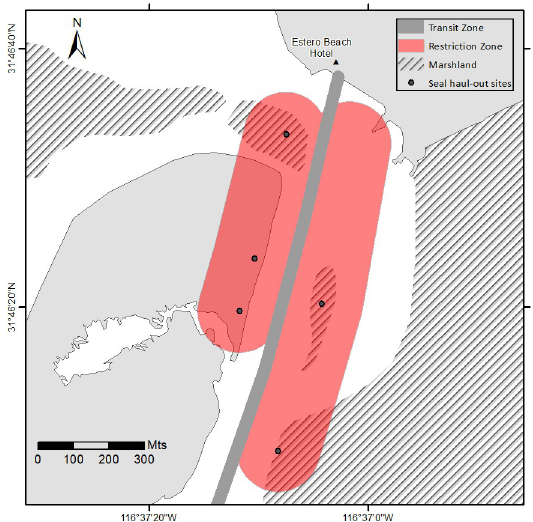
Fig 6. Zoning proposal for PBE with the objective of restricting both land and sea access to the harbor seal haul- out sites. The strategy proposed would be enforced by local authorities during the pupping season, from February to April, each year. Basemap source: IMIP ( Instituto Metropolitano de Investigación y Planeación de Ensenada , Baja California , or Ensenada Metropolitan Research and Planning Institute, Baja California), “ SIG y mapas en línea ”–“ Imágenes digitales de alta resolución (línea de costa-El Sauzal) ”, or GIS and online maps–High resolution digital images (El Sauzal coastline).